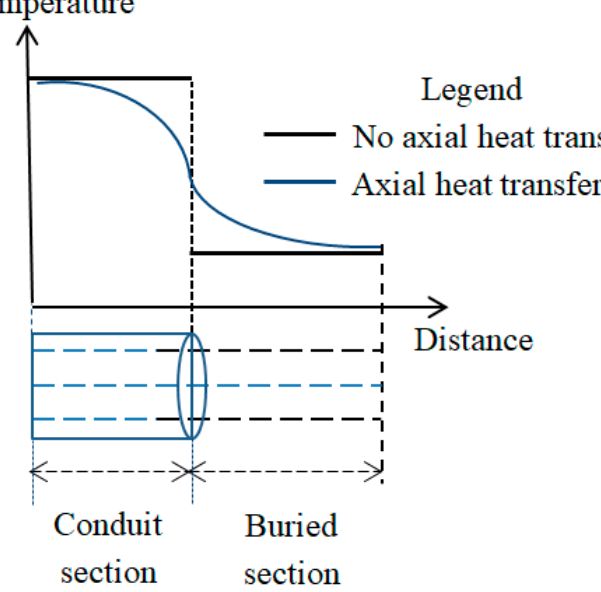
Figure 7. Heat transfer in the axial direction for a short-conduit cable (adapted from [74]).